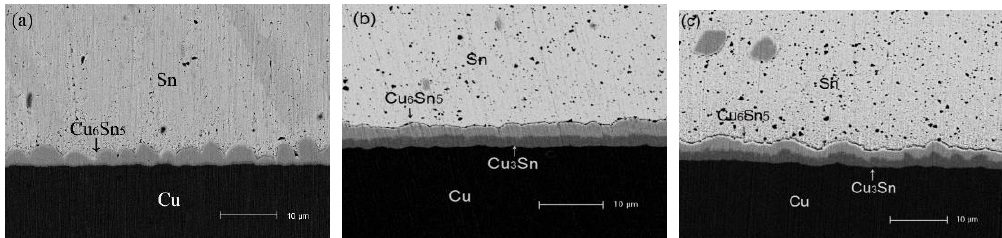
Figure 1. Interfacial microstructure of Sn/HP Cu joints after aging at 150 °C for ( a ) 0 h, ( b ) 240 h, and ( c ) 480 h.